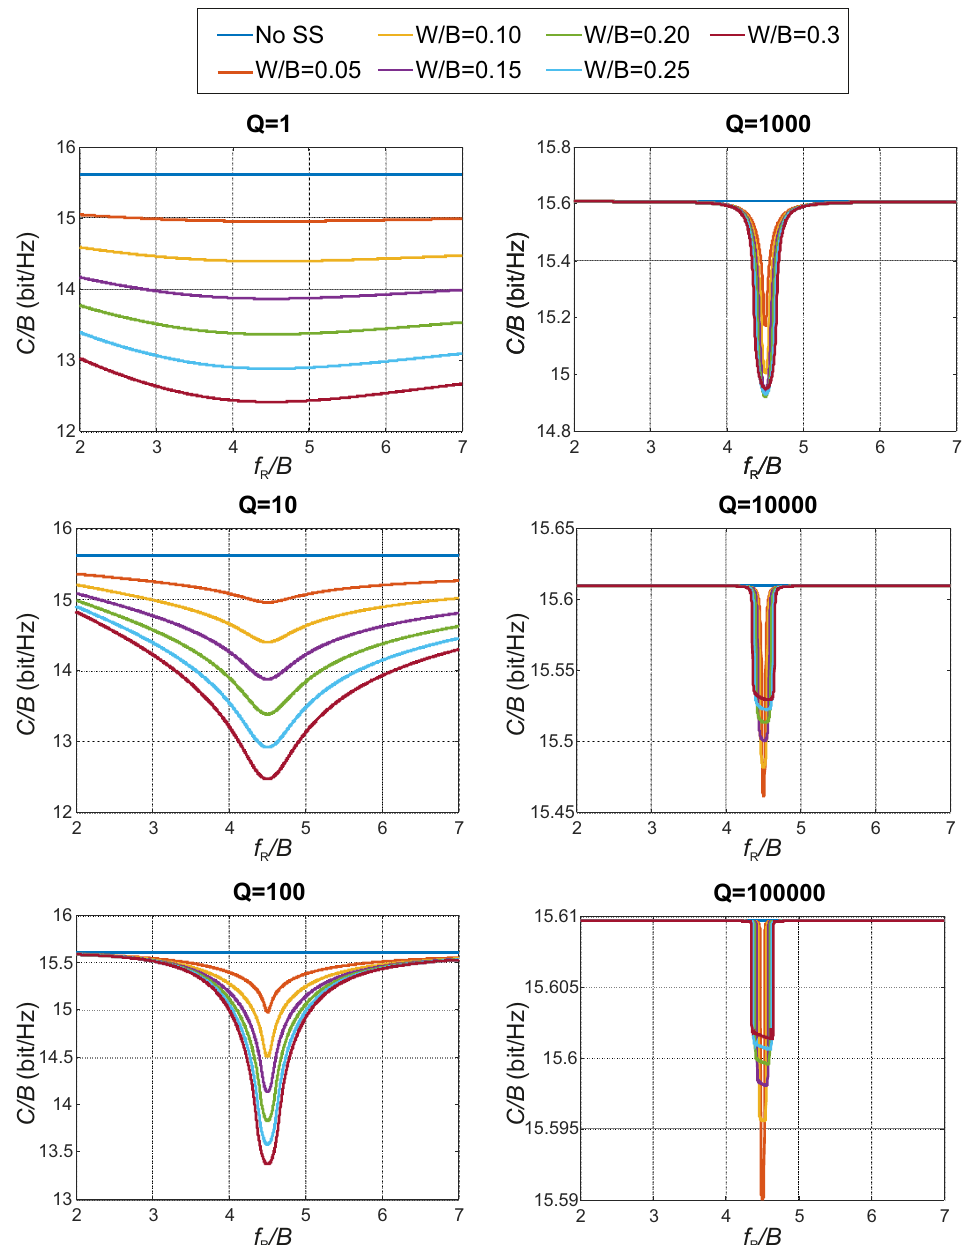
Figure 5. Normalized capacity versus resonant frequency f R / B for the channel in Figure 3 for different values of the resonant coupling quality factor Q under constant peak coupling, reported in each plot for different SS-modulation depth δ ranging from 0 (no SS) to